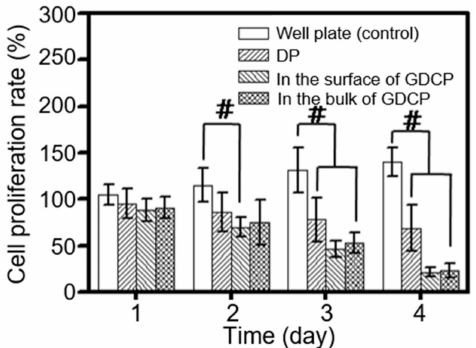
Figure 3. In vitro cell proliferation rates of MCF-7 breast cancer cells cultured on control, DP, and GDCP at 37 ◦ C for 1, 3, 5, and 7 days. This experiment was carried out three times ( # p < 0.05). These values were expressed as the mean ± standard